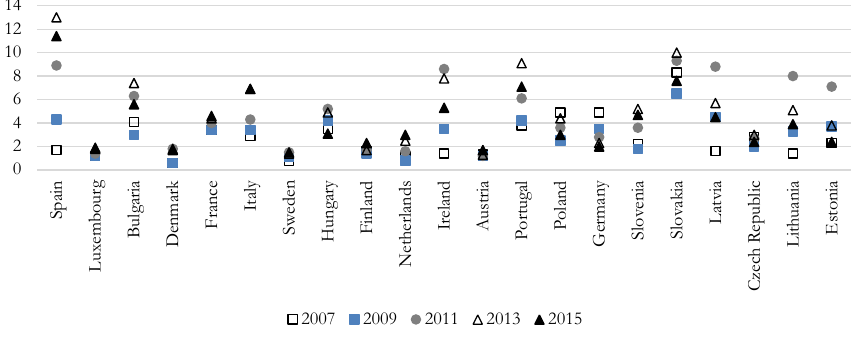
Fig. 4 – Long-term unemployment, 2007 – 2015, % of active population. Source: Eurostat (2017). In 2009, one third of the unemployed in selected countries had been without work, and this share increased each year. The lowest long-term unemployment rate was in Nordic Member States, Denmark, Sweden, and Finland. Austria and Luxemburg registered minor increases in long-term unemployment. The strongest decrease over the period can be seen in Germany. On the contrary, the highest long-term unemployment was reported in Spain, Bulgaria or Slovakia. Insignificant changes in the development of the long-term unemployment occurred in Luxem- bourg, Sweden, and Austria. Significant fluctuations of the indicator were in Spain, Ireland, Latvia and Lithuania The following dendrograms (Fig. 5) display the groups of countries in 2007 (on the left) and 2009 (on the right) according to selected input variables listed in Section 3. The characteristics of individual clusters (from left to right) are shown in Tab.